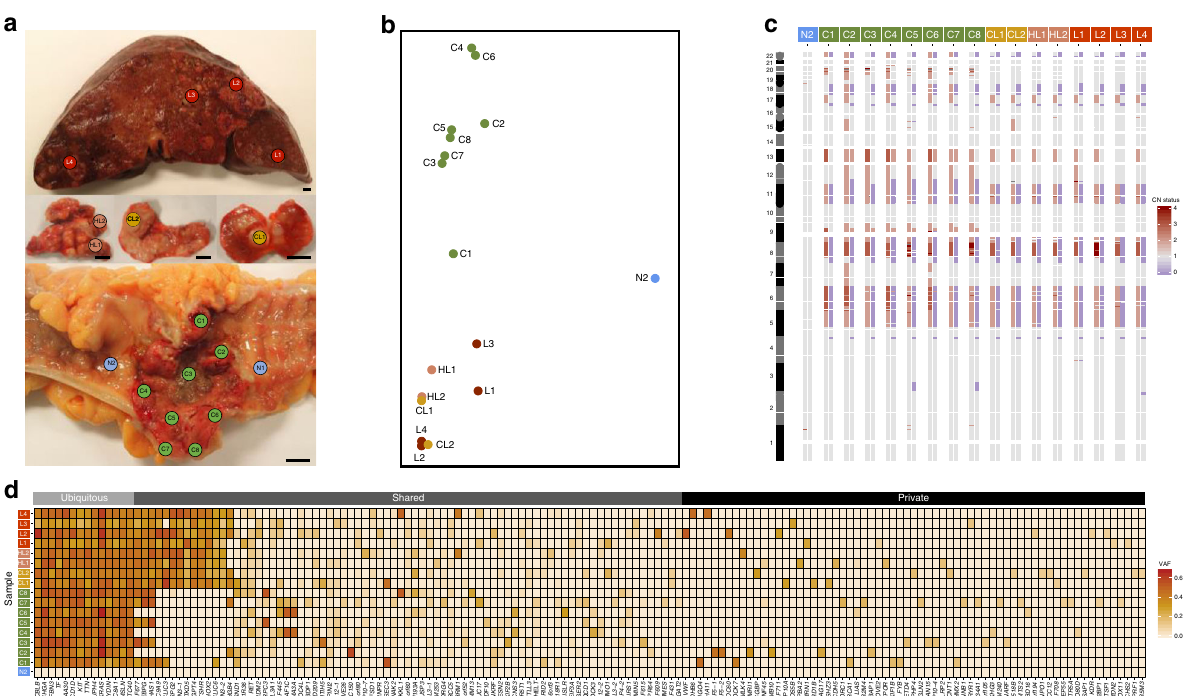
Fig. 1 Genomic pro fi les of bulk tumor samples. a Multiregional sampling scheme. A total of 18 samples were collected, including two samples from healthy tissue (in blue), eight from the primary tumor (green), two from proximal colonic lymph nodes (gold), two from distal hepatic lymph nodes (salmon), and four from liver metastasis (red). Scale bar: 1 cm. b Principal component analysis (PCA) with variant allele frequencies (VAF) for all 475 somatic mutations detected. Each circle corresponds to a given sample, with colors highlighting the anatomical regions. c Heatmap depicting genome-wide allele-speci fi c copy-number status (from 0 in blue to 4 in red) of healthy and tumor samples. Sample IDs are shown at the top. d Heatmap with the observed allele frequencies (from 0 in white to 0.65 in red) of somatic mutations identi fi ed in the sequenced samples. Here only the non-synonymous mutations are shown ( n = 156), sorted according to their mean VAF across all tumor samples. Gene names are displayed at the bottom of the map. Each row represents